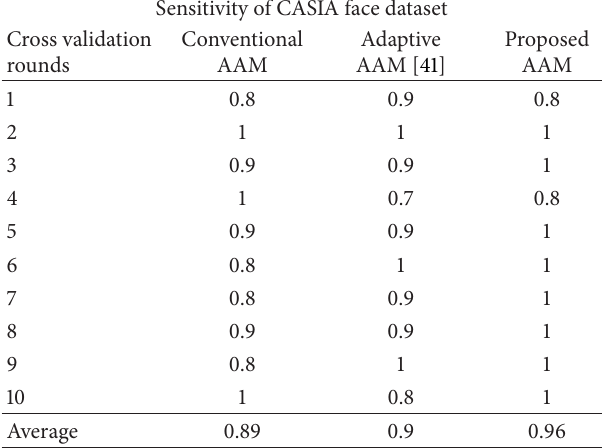
Table 4: Cross validation results for 2.5D face dataset in terms of accuracy for conventional AAM, adaptive AAM, and the proposed AAM.